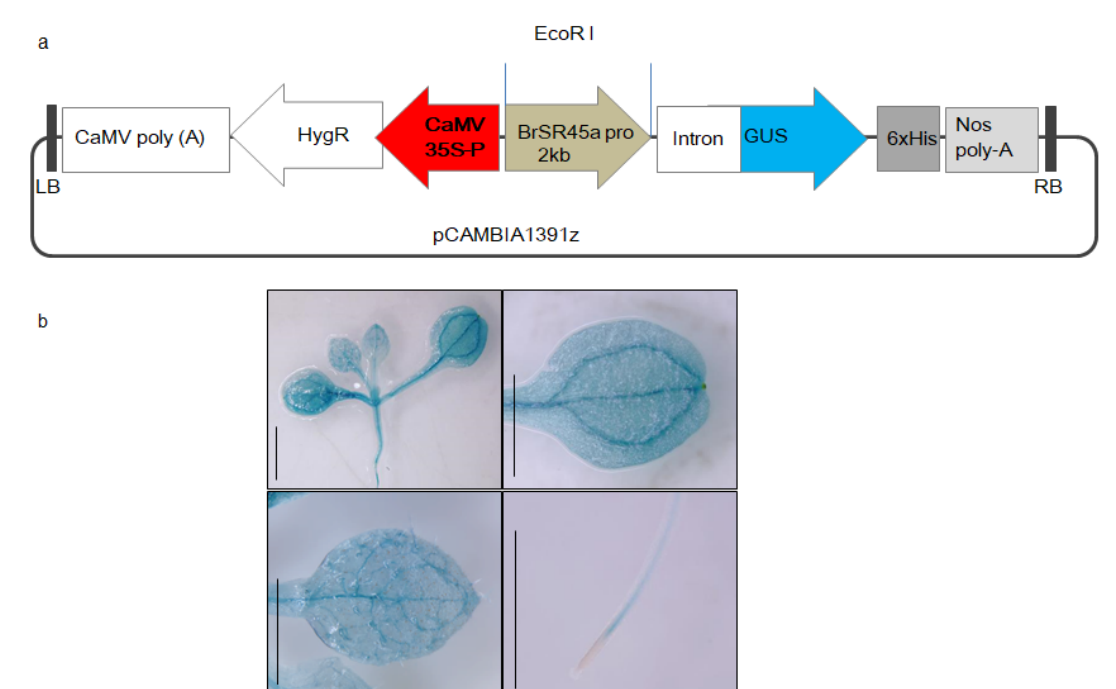
Figure 2. Development of transgenic reporter Arabidopsis lines expressing GUS under the promoter activity of B. rapa SR45a. The representative vector map of pCAMBIA1391Z ( a ), which was used for BrSR45a promoter characterization and ( b ) the measurement of GUS activity in transgenic reporter Arabidopsis lines ( BrSR45a promoter:: GUS ) expressing GUS under the promoter of BrSR45a.